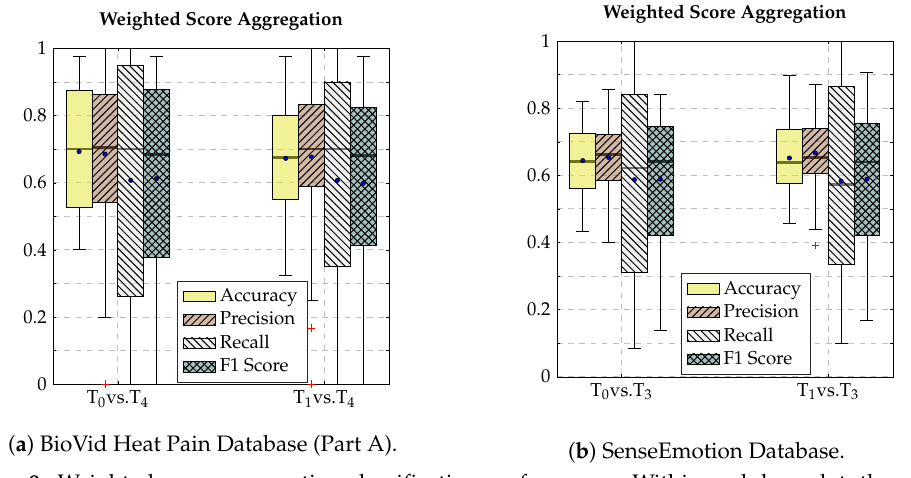
Figure 9. Weighted score aggregation classification performance. Within each box plot, the mean and median values of the respective performance evaluation metrics are depicted with a dot and a horizontal line,